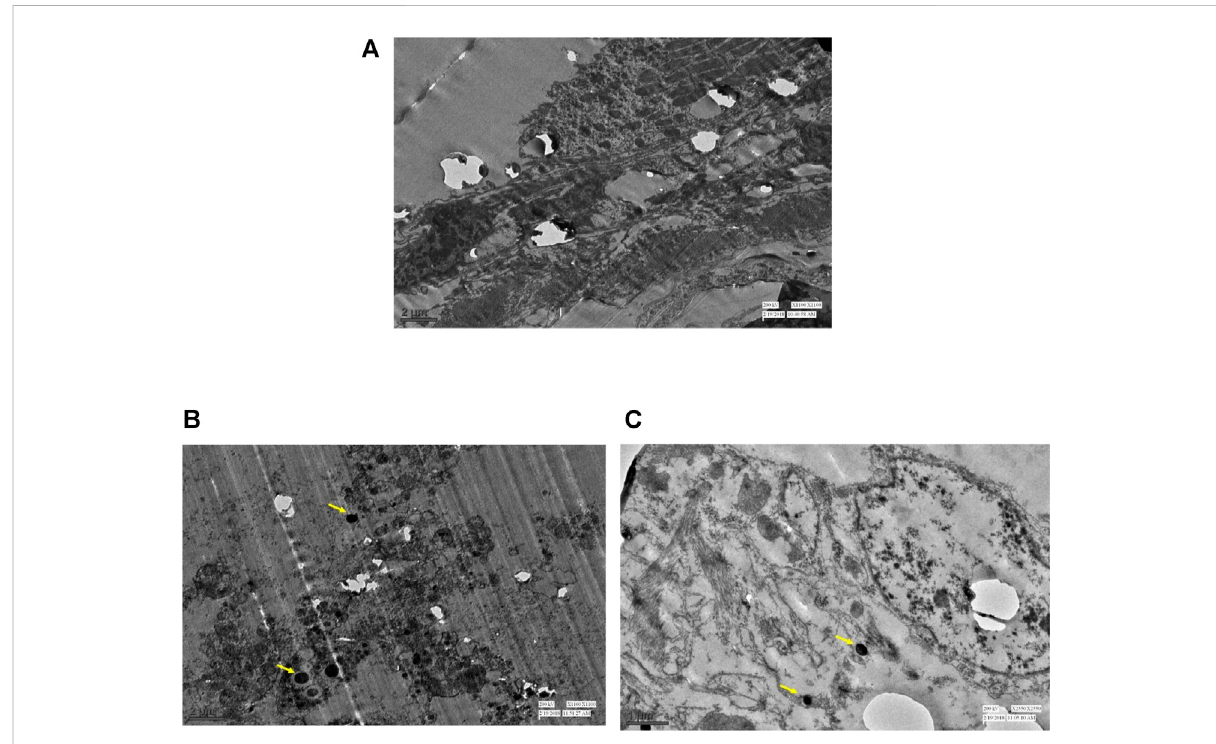
FIGURE 6 TEMimagesofthecellularorganizationofearlyfourthinstarsof Aedesaegypti mid-gut: (A) control; (B) larvaexposedto Achyranthesaspera leaf extract-mediated silver nanocomposites (AL-AgNCs); (C) larva exposed to Achyranthes aspera stem extract-mediated silver nanocomposites (AS- AgNCs); and ( → ) indicates deposition of black